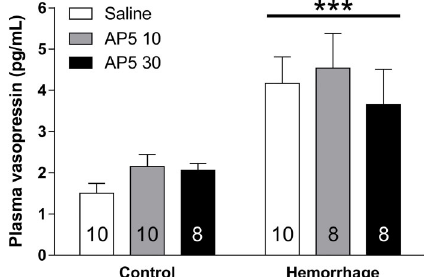
Figure 1. The intracerebroventricular administration of AP5 did not affect plasma arginine vasopressin (AVP) after hemorrhage. This result suggests that L-glutamate NMDA receptors are not necessary for hemorrhage-induced AVP secretion. Data are reported as means ± SE. ***F (1,48) =23.73, P o 0.001 compared to control (no hemorrhage) (ANOVA). Numbers in columns indicate the number of animals/group.